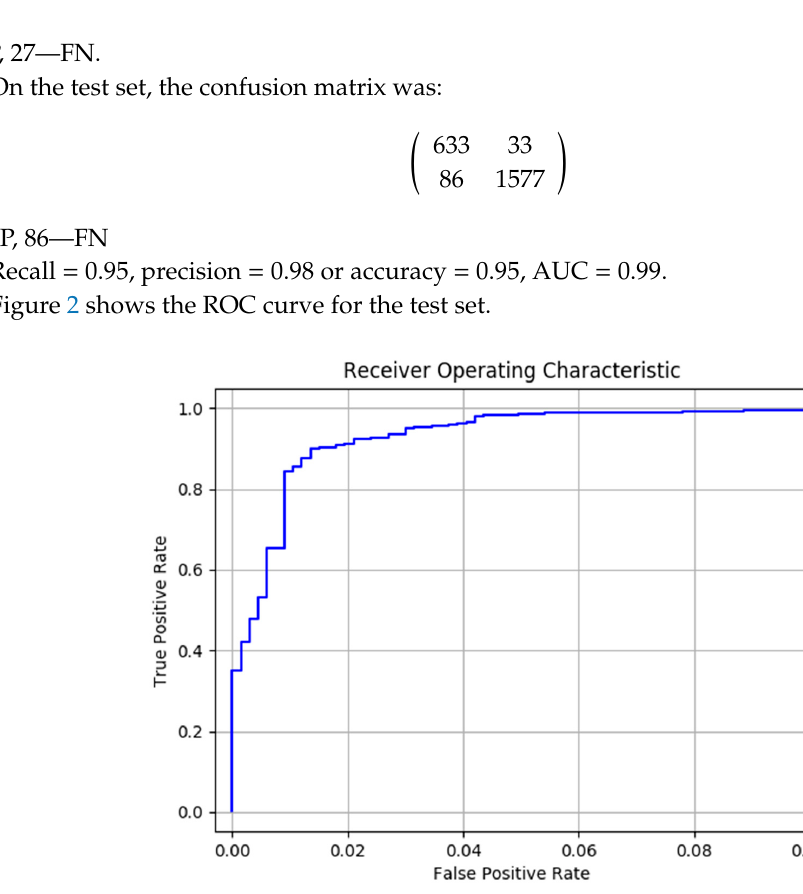
Figure 2. ROC curve for the test set.